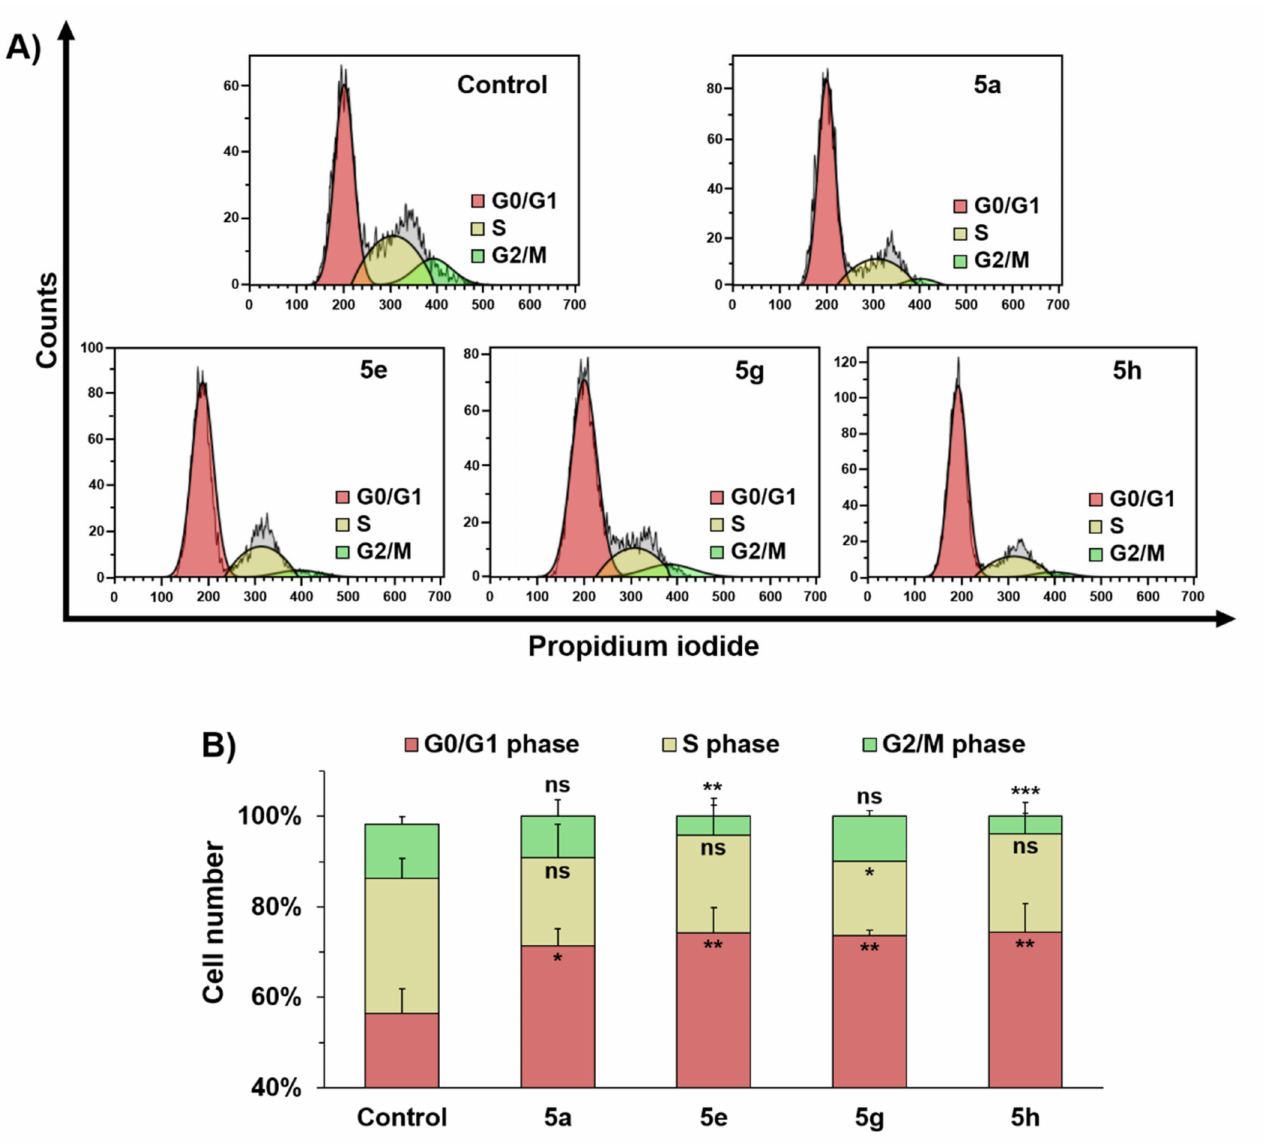
Figure 4. Flow cytometry cell cycle analysis of MCF-7 cells exposed for 24 h to IC 50 concentrations of 5a , 5e , 5g , and 5h and 0.5% DMSO vehicle (control). ( A ) Cell cycle histogram plots show a single representative experiment. ( B ) Cell cycle distribution of MCF-7 cells treated with IC 50 concentrations of 5a , 5e , 5g , and 5h and 0.5% DMSO vehicle for 24 h. Data are presented as mean ± SD; n = 3. Statistical significances are referred to the DMSO control. Differences between groups were determined by analysis of variance (ANOVA), and Dunnett’s test was used for multiple comparisons with the control. * p < 0.05; ** p < 0.01; *** p <